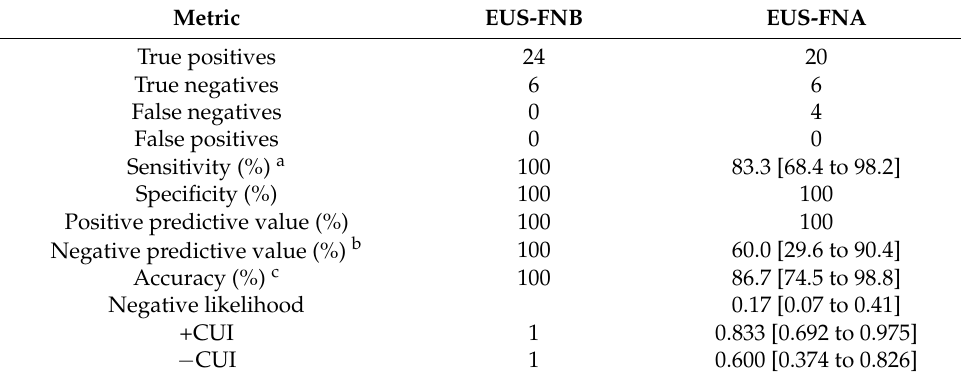
Table 3. Diagnostic metrics in EUS-FNB and EUS-FNA